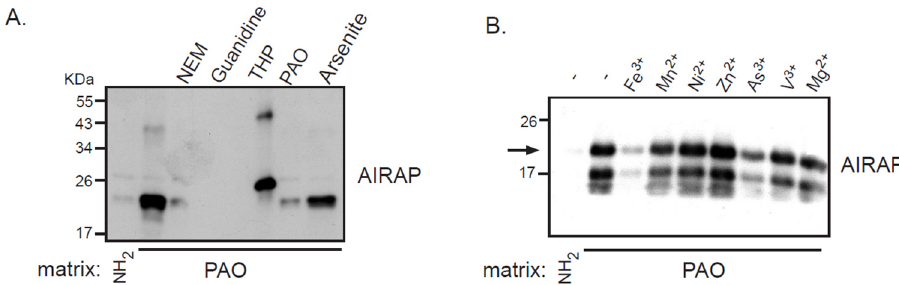
Figure 1. Recombinant AIRAP binding to a PAO matrix. ( A ) Recombinant mouse AIRAP was expressed as a C-terminus 6 × His fusion protein and Ni-NTA affinity purified. Purified material was incubated with a control (NH 2 ) or amino-phenylarsine (PAO) immobilized Sepharose 4B matrix in the presence of the cysteine alkylating N -ethylmaleamide (NEM), denaturing conditions (6M guanidine–HCl), reducing conditions (THP), sodium arsenite (As) or soluble amino-phenylarsine (PAO). Immobilized material was extensively washed, eluted by boiling with 2% SDS and subjected to SDS-PAGE and subsequent immunobloting to evaluate AIRAP content. ( B ) The impact of metals on AIRAP binding to a PAO matrix was performed as in 1A by performing the binding in the presence of the indicated metals. The arrow indicates the full-length recombinant product of AIRAP.